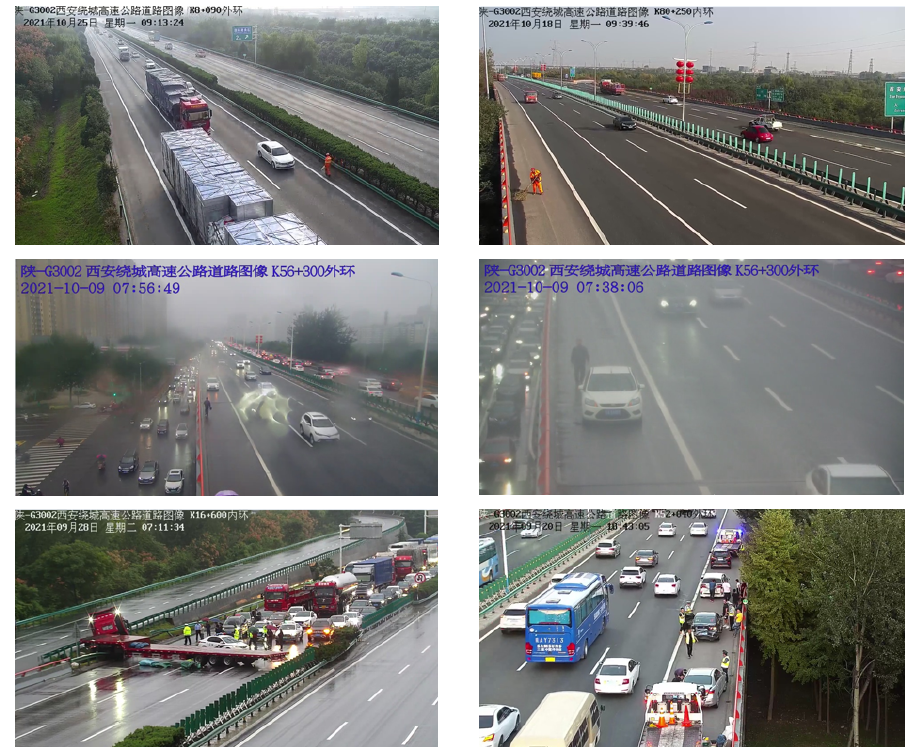
Figure 1. Intuitive examples to explain the three main problems of object detection on traffic scene images. The cases in the first, second and third rows show the problems of large object size variations, blurred images and tiny object sizes that are difficult to detect, respectively. (The Chinese words in the image are the time and place recorded by the surveillance